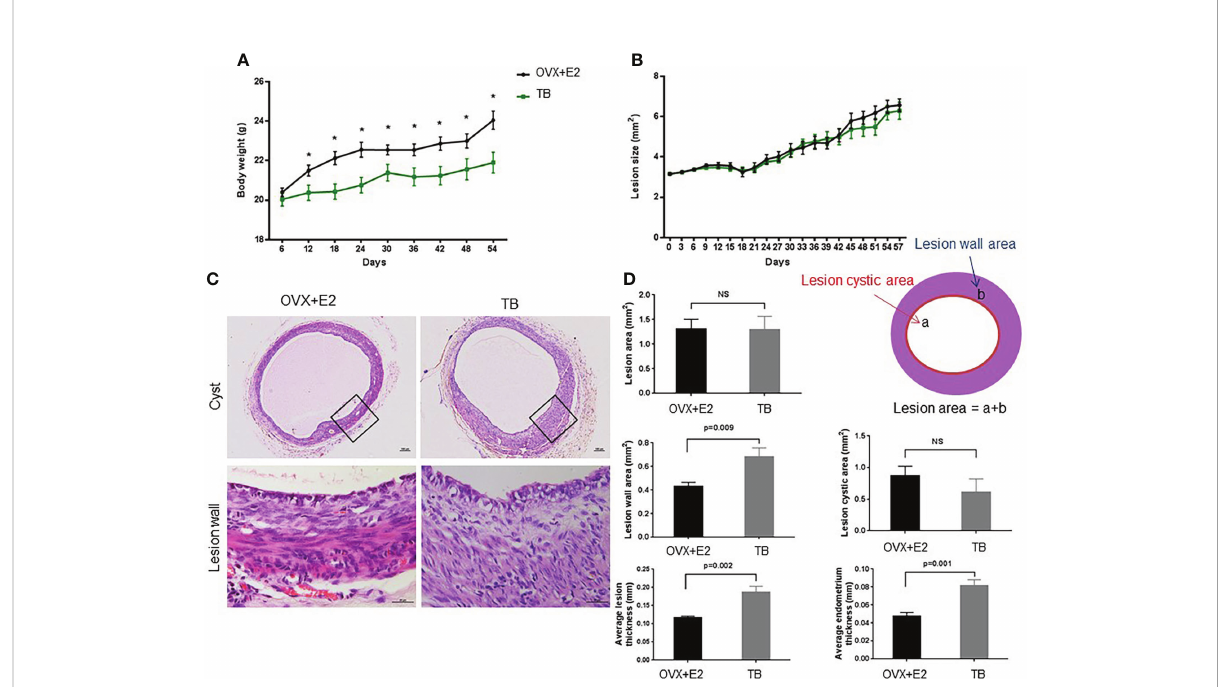
FIGURE 3 Dynamic changes of (A) body weight and (B) lesion size after inducing endometriosis. OVX+E2, ovariectomy with estrogen supplement group; TB, male urine-soaked transfer bedding group. (C) Representative hematoxylin and eosin-stained images of endometriotic lesions from mouse model of endometriosis at 2 months post-induction. Cyst scale bar, 100 m m. Lesion wall scale bar, 25 m m. (D) Endometriotic lesions growth parameters post-induction. Data are shown as mean ± SEM, n = 8, for each group. * p < 0.05 by independent t-test or ANOVA. NS, no signi fi